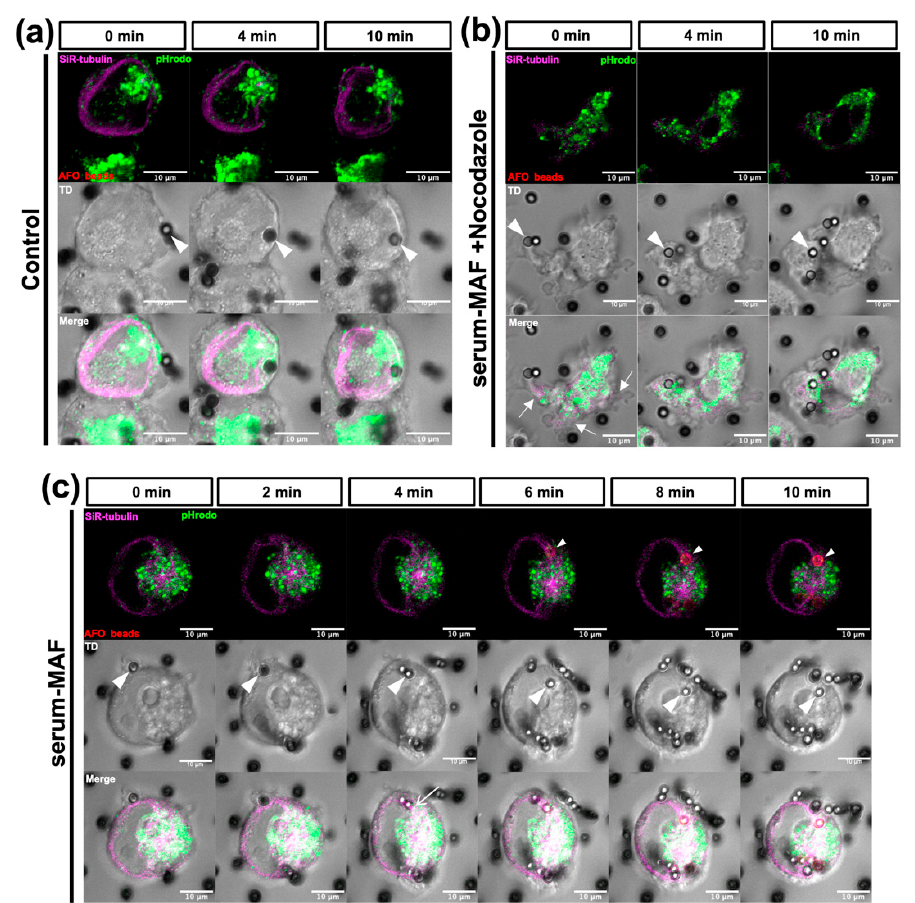
Figure 6. Translocation of the internalized beads and lysosome. Time-lapse recordings of macrophages stained with SiR-tubulin (magenta) for microtubules, pHrodo (green) for the lysosome, and AFO-beads (red) for acidification were conducted. Photographs at the indicated time periods after the bead of interest contacted the cell surface were selected from the movies. Beads of interest are indicated by arrowheads. ( a ) Control macrophage (without serum-MAF activation). The control macrophage, which internalized the beads at 4 min after the addition of the beads, was the rare and fastest case. The internalized bead was surrounded by the lysosome, while it had not yet acidified in 10 min. ( b ) Nocodazole and the serum-MAF-treated macrophage. The distorted cell shape with the elephant-nose-like cytoplasmic protrusion and extended flat and thin lamellipodia are shown (small arrows). ( c ) The serum-MAF-treated macrophage. The small lysosome was in contact with an internalized bead at 4 min in the serum-MAF-activated macrophage (arrow) and the bead started to emit fluorescence at 6 min (small arrowhead). Scale bars: 10 µm.